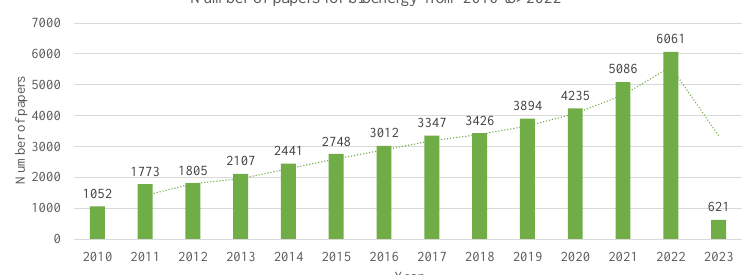
Figure 8. Development of research in bioenergy (2010–2022). The dotted line represents the moving average of the published